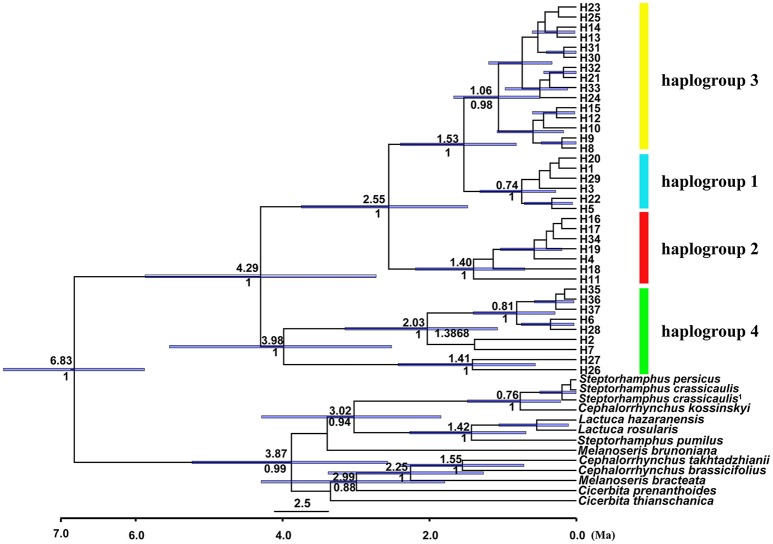
BEAST-derived chronogram for cpDNA haplotypes of Parasyncalathium souliei, indicating the four main haplogroups. For deeper nodes, the 95% highest posterior density interval (purple bars), the time of divergence (above branch) and posterior probabilities > 0.5 (below branch) are provided.